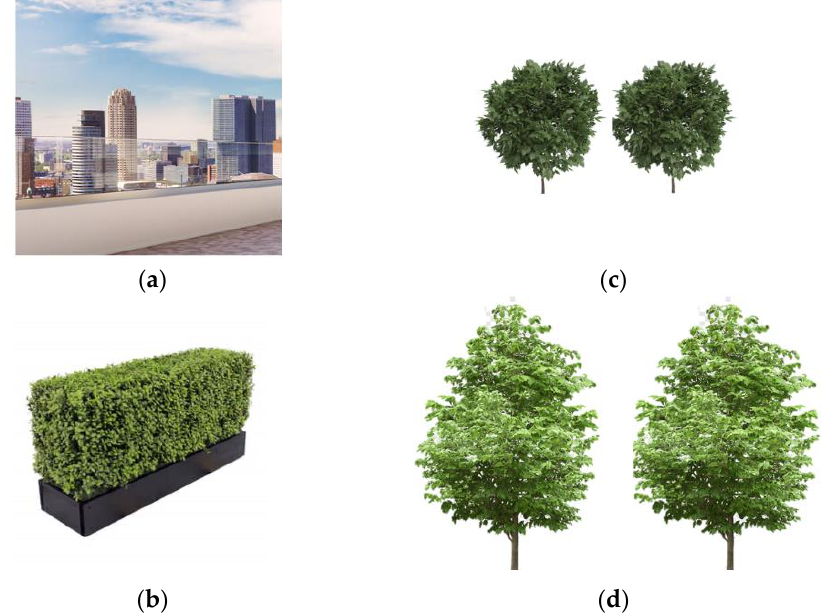
Figure 1. Wind barrier elements used in skygarden design; ( a ) railing or windscreen, ( b ) hedge, and ( c ) small and ( d ) large trees.